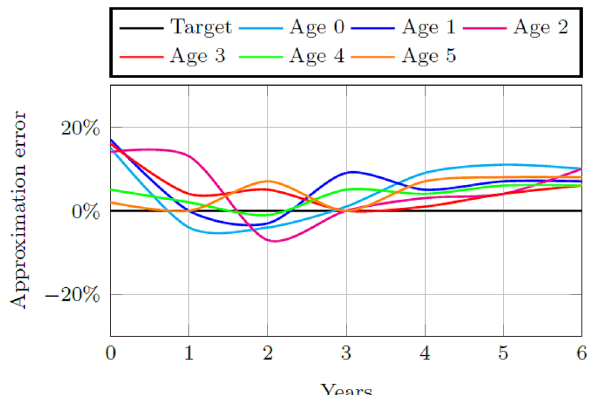
Fig. 5 Model approximation of reality for the calibrated weights for the number of ECD enrolled children per age group in Quintiles 4 and 5